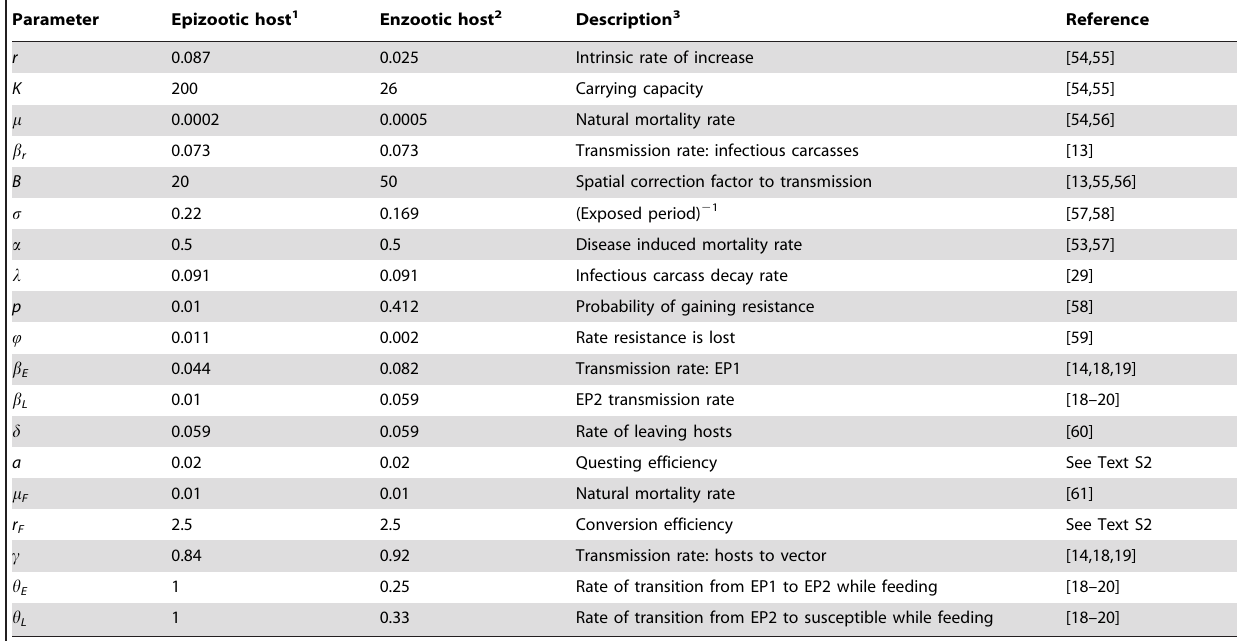
Table 2. Parameter values.